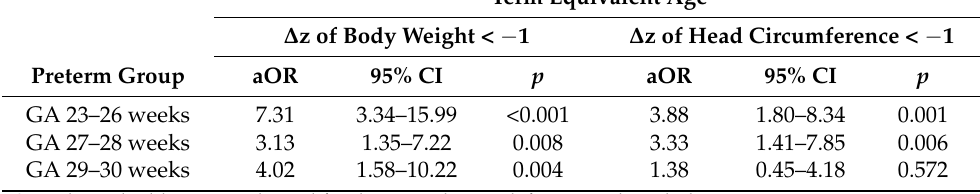
Table 4. Adjusted odds ratios of extrauterine growth restriction in body weight and head circumfer- ence at term-equivalent age after the adverse feeding trajectory in infants across the three gestational age preterm